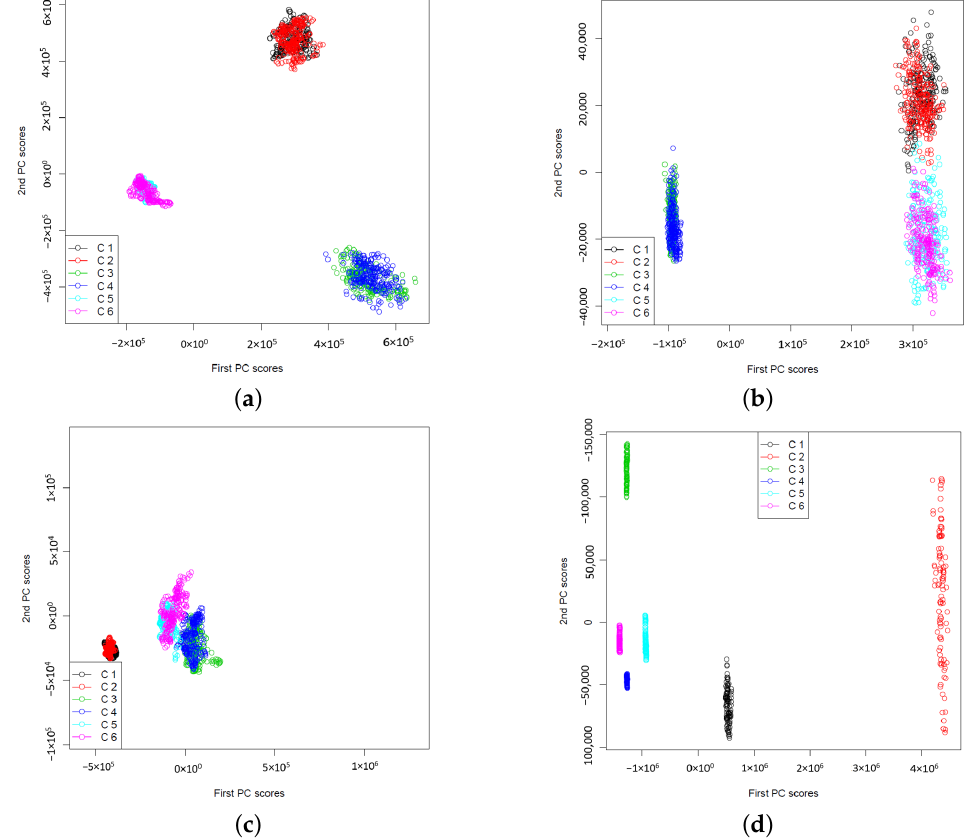
Figure 10. The plots of extracted two-dimensional features of DWT wavelet power spectra of patient specific ictal EEG signals. The maximum number of B-splines basis functions are used to smooth the sample wavelet power spectra, i.e., K = 10. ( a ) Patient 1, ( b ) Patient 3, ( c ) Patient 4, ( d ) Patient 6.